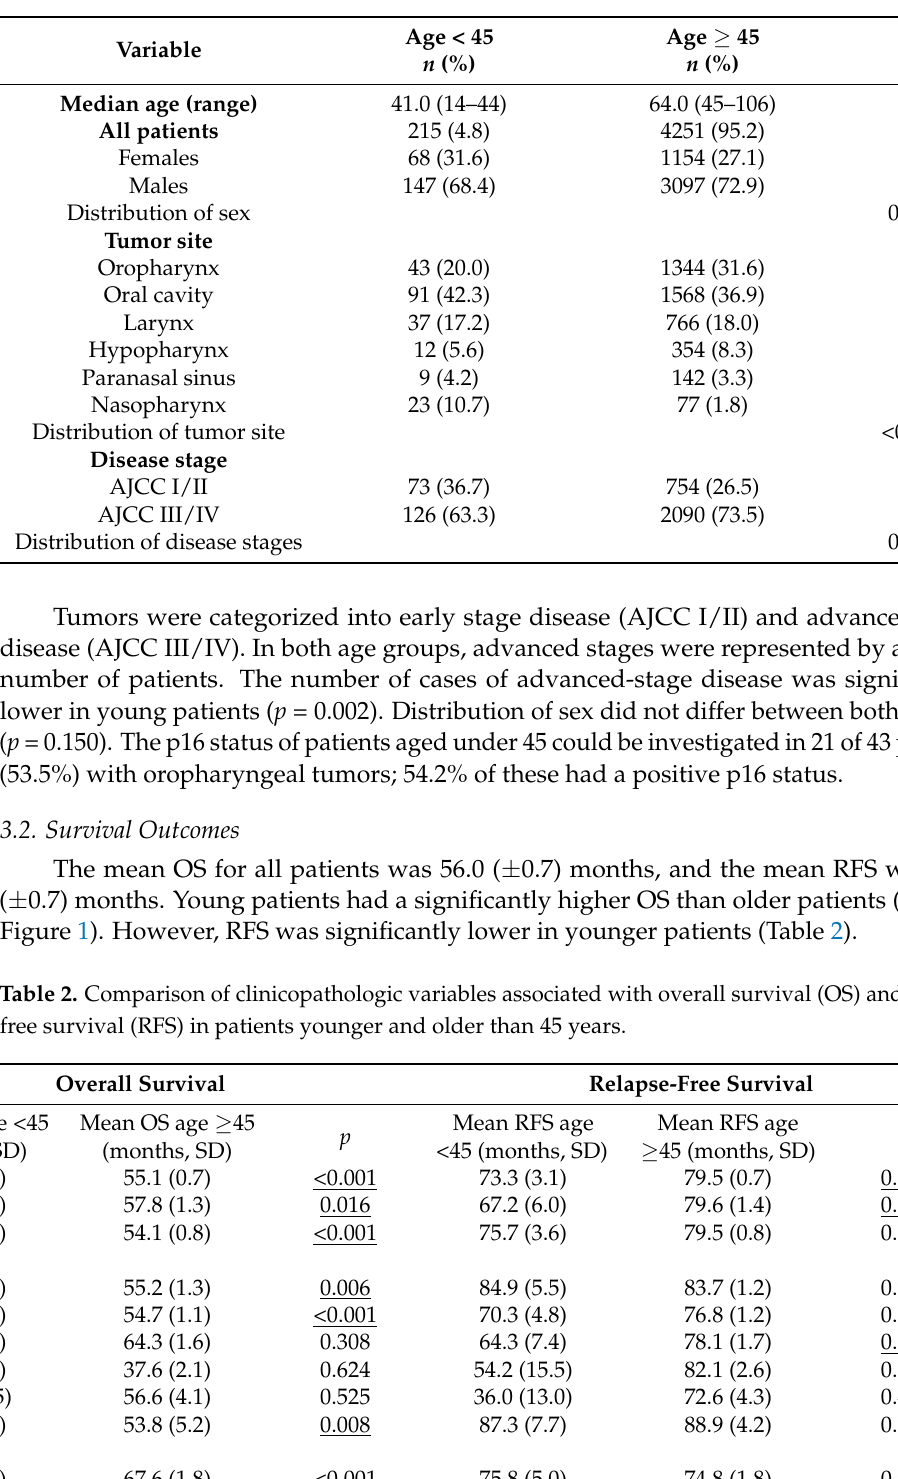
Table 1. Characteristics of patients with primary diagnosed head and neck malignancies.